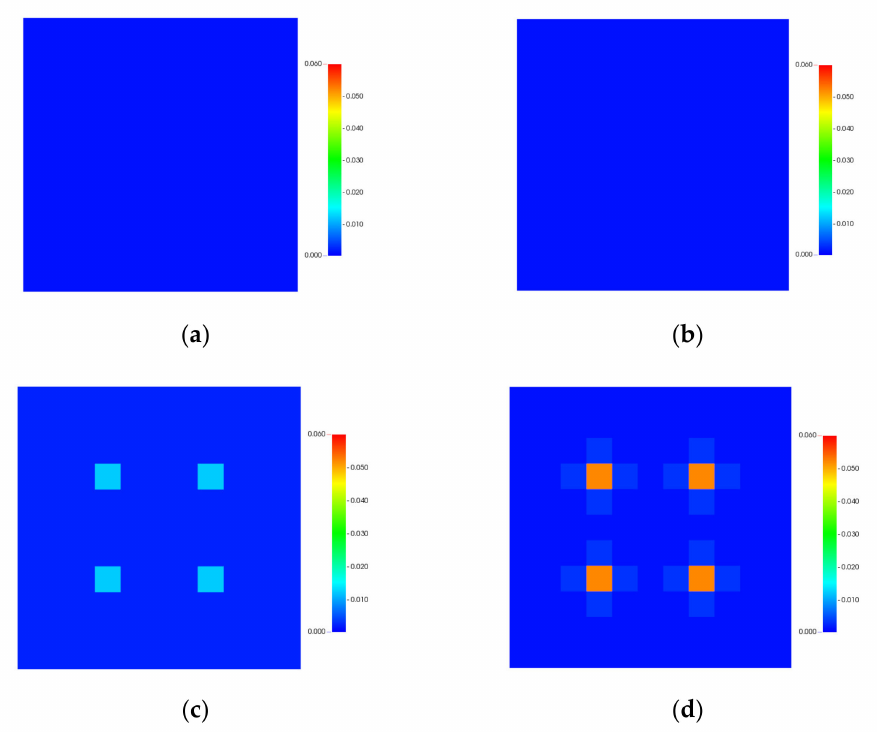
Figure 8. Reservoir oil saturation profiles calculated by CMG. ( a ) The 0.001th day; ( b ) the 10th day; ( c ) the 30th day; ( d ) the 200th